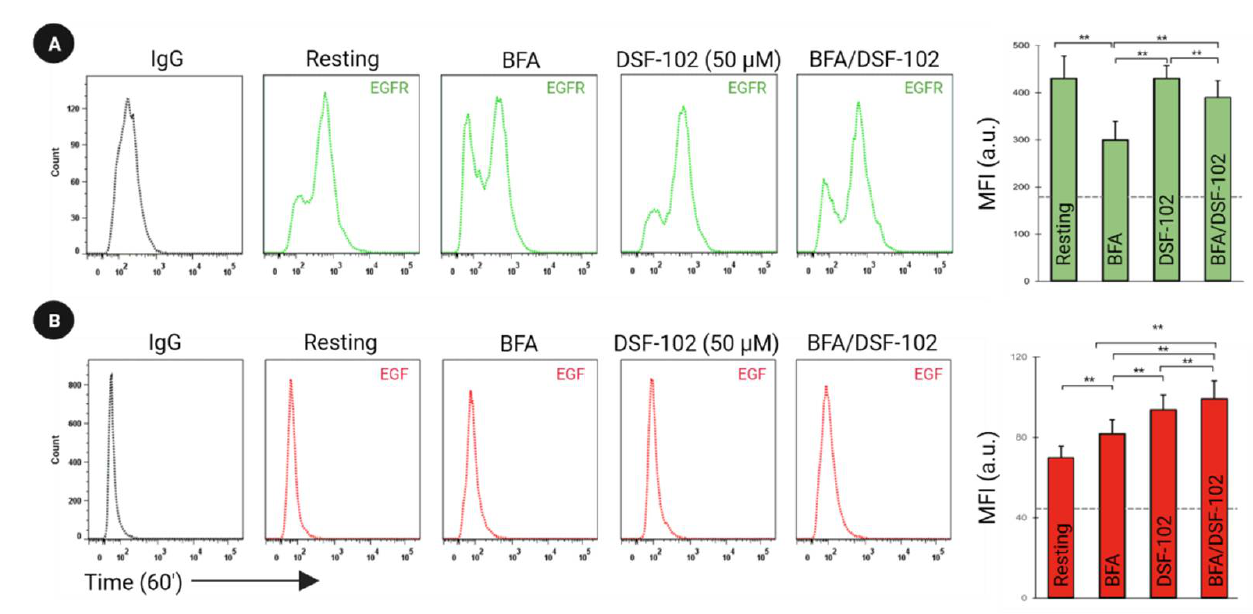
Figure 6. Flow cytometry analysis of ( A ) membrane EGFR (green line) and ( B ) intracellular EGF (red line) at 60 min of stimulation with 50 µ M DSF-102 alone or combined with brefeldin A (BFA/ DSF-102 ). Resting cells and BFA-treated samples were used as controls. To detect only intracellular EGF, flow cytometry was coupled with acid washing. Data were expressed as MFI ± SEM. ** ( p ≤ 0.01).